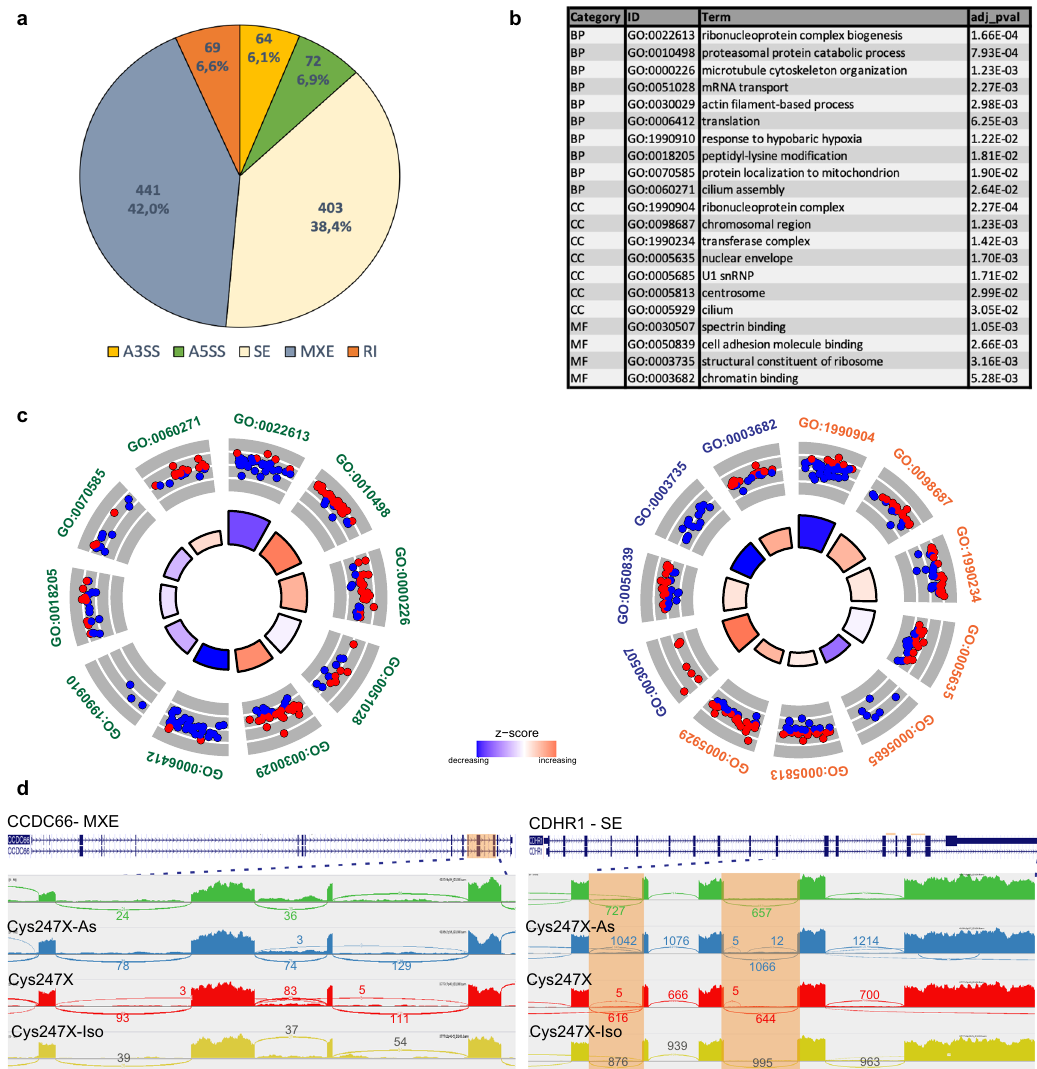
Fig. 11 Identi fi cation of alternate splicing in D100 retinal organoids derived from PRPF31 patient hiPSCs. a Pie chart from rMATs analysis showing that a majority of splicing events in retinal organoids corresponded to skipped exons and mutually exclusive exons. A5SS and A3SS, alternative 5 ′ and 3 ′ splice sites; SE, skipped exons; RI, retained introns; MXE, mutually exclusive exons. b Table showing pathway identity number (ID), associated pathway name (Term), gene count from pathways analysis and the adjusted P value (adj_pval). The different categories of pathways are BP, Biological Process; CC, Cell Compartment; MF, Molecular Function. c Circular visualization of selected GO enriched pathways from the identi fi ed 600 genes with alternative splicing events (total of 1049 splicing events) between Cys247X-Iso and Cys247X retinal organoids at D100. Down- (blue dots) and up-regulated genes (red dots) within each GO pathway are plotted based on logFC. z score bars indicate if an entire biological process is more likely to be increased or decreased based on the genes it comprises. Green, Biological Process; orange, Cell Compartment; blue, Molecular Function. d Sashimi plots for the indicated genes representing the alternate splicing events in retinal organoids at D100 derived from Control (green), Cys247X-As (blue), Cys247X (red) and Cys247X-Iso (yellow). Data are representative of the replicates for each experimental group. Orange highlights in the sashimi plots indicate the alternative splicing events and numbers correspond to the number of junction reads for each event. CCDC66: Coiled-Coil Domain Containing 66; CDHR1: Cadherin Related Family Member